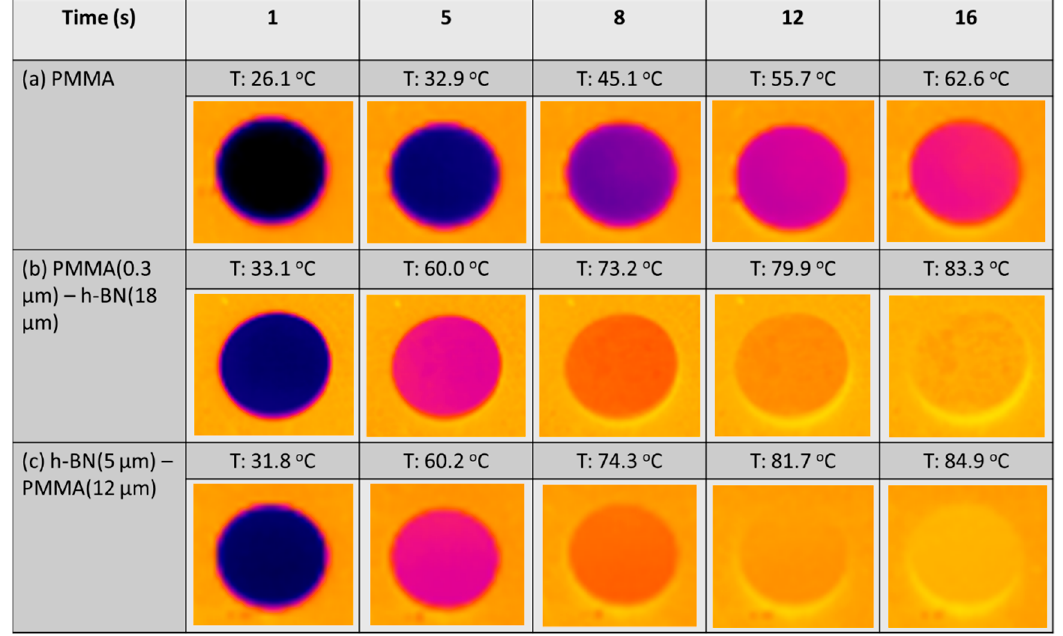
Figure 6. Thermograph images of ( a ) PMMA, ( b ) PMMA (0.3 µm)/hBN (18 µm). and ( c ) hBN (5 µm)/PMMA (18 µm) composite pellets after infrared thermography irradiation.